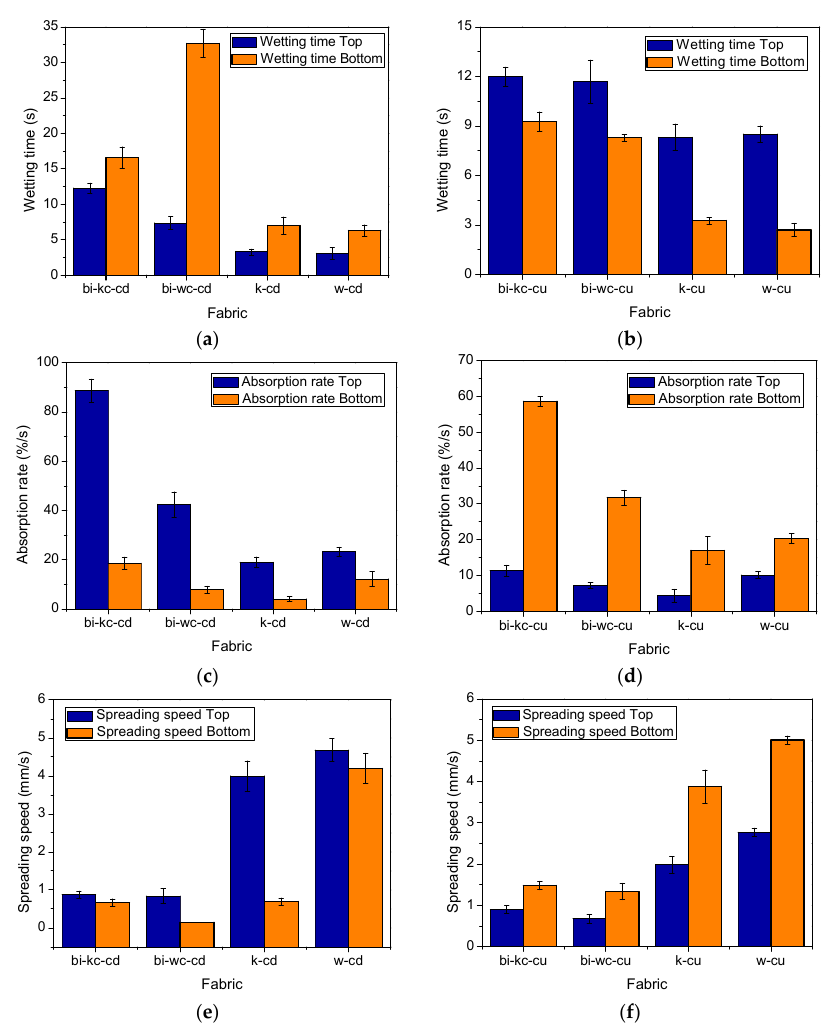
Figure 9. Comparisons of different fabrics by the MMT indices: ( a , b ) wetting time; ( c , d ) maximum absorption rate; ( e , f ) spreading speed. The ‘Top’ means the upper face of the sample in the MMT, and the ‘Bottom’ means the lower face of the sample in the MMT. Table 3. The one ‐ way transport capacity (OWTC, %) results in value of fabric samples. Bifacial fabric with knitted face up 173.4 − 289.4 Fabric Sample 115.2 − 216.1